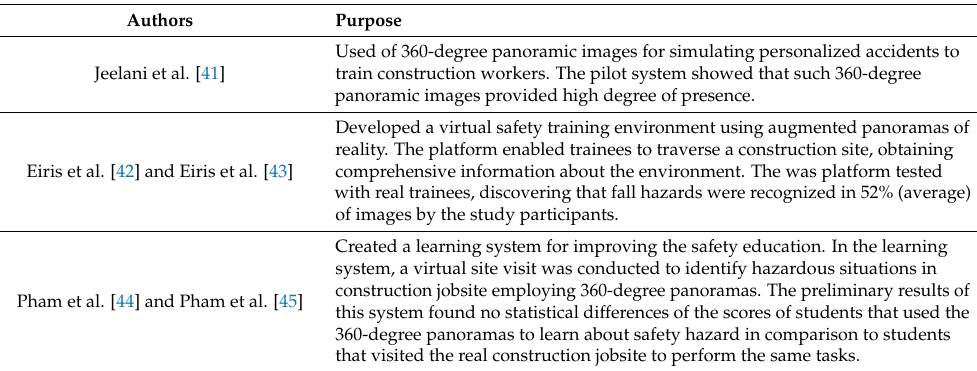
Table 2. 360-Degree Panorama Applications for Safety